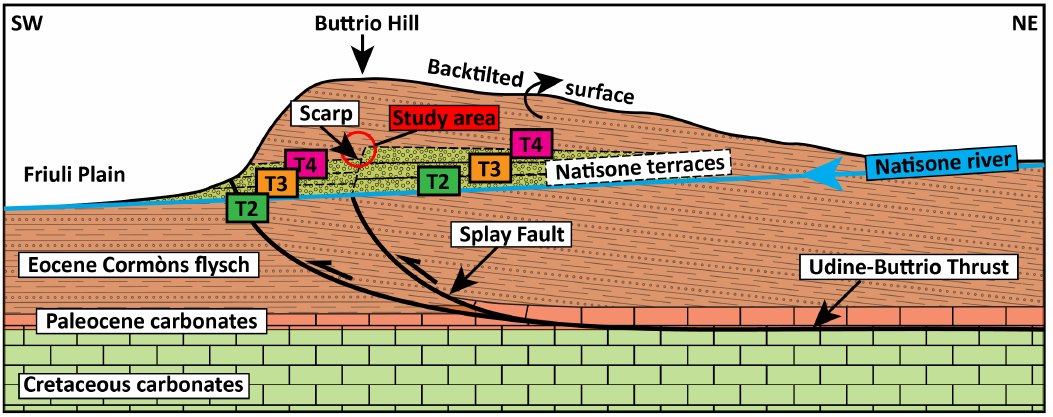
Figure 13. Conceptual sketch of the study site encompassing the Buttrio Hill, outcome of the Quaternary activity of the Udine-Buttrio Thrust, and the Natisone River terraces, affected by the activity of the splay fault. The sketch is not to scale and the topography is exaggerated. Geology is adapted from Galadini et al.